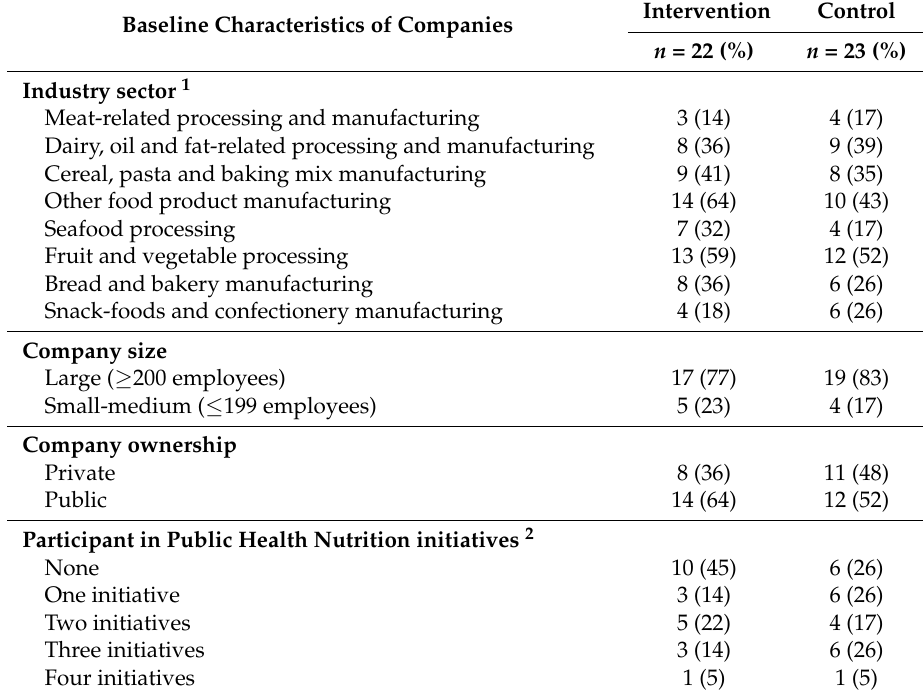
Table 2. Baseline characteristics of included companies, N = 45